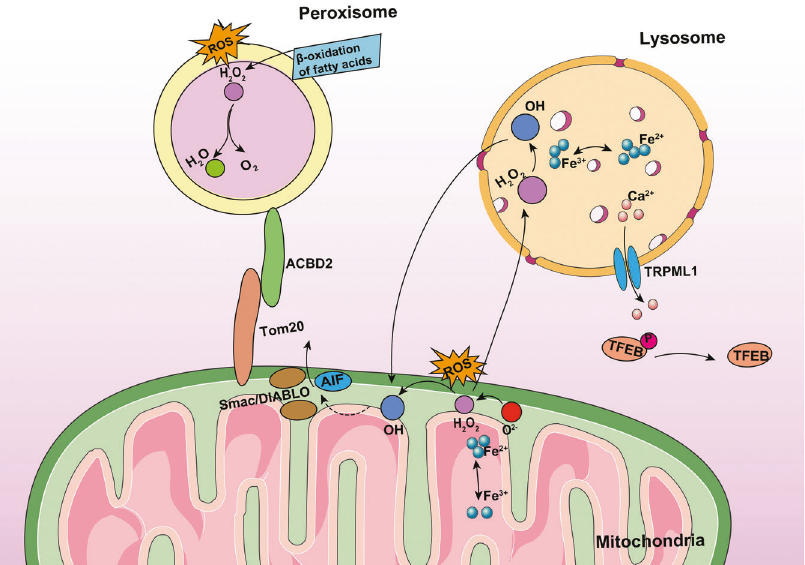
Fig. 3 Crosstalk between mitochondria and other organelles. Elevated ROS levels within mitochondria causes TRPML1 to activate more lysosomal Ca 2 + export channels to the cytoplasm. Elevated Ca 2 + activates calcineurin, which dephosphorylates TFEB and increases cellular phagocytosis. H 2 O 2 is one of the major members of ROS. H 2 O 2 produced by mitochondria or other sites diffuses into lysosomes. Lysosome catalyzes the conversion of H 2 O 2 to OH by the Fenton reaction. OH can disrupt the lysosomal membrane, resulting in leakage of lysosomal enzymes into the cytoplasm. Lysosomal enzymes can penetrate the outer membrane of mitochondria, allowing Smac/DIABLO and AIF to be released. Tom20 and ACBD2 participate in mitochondria – peroxisome connection, and promote substance transfer between the mitochondria and